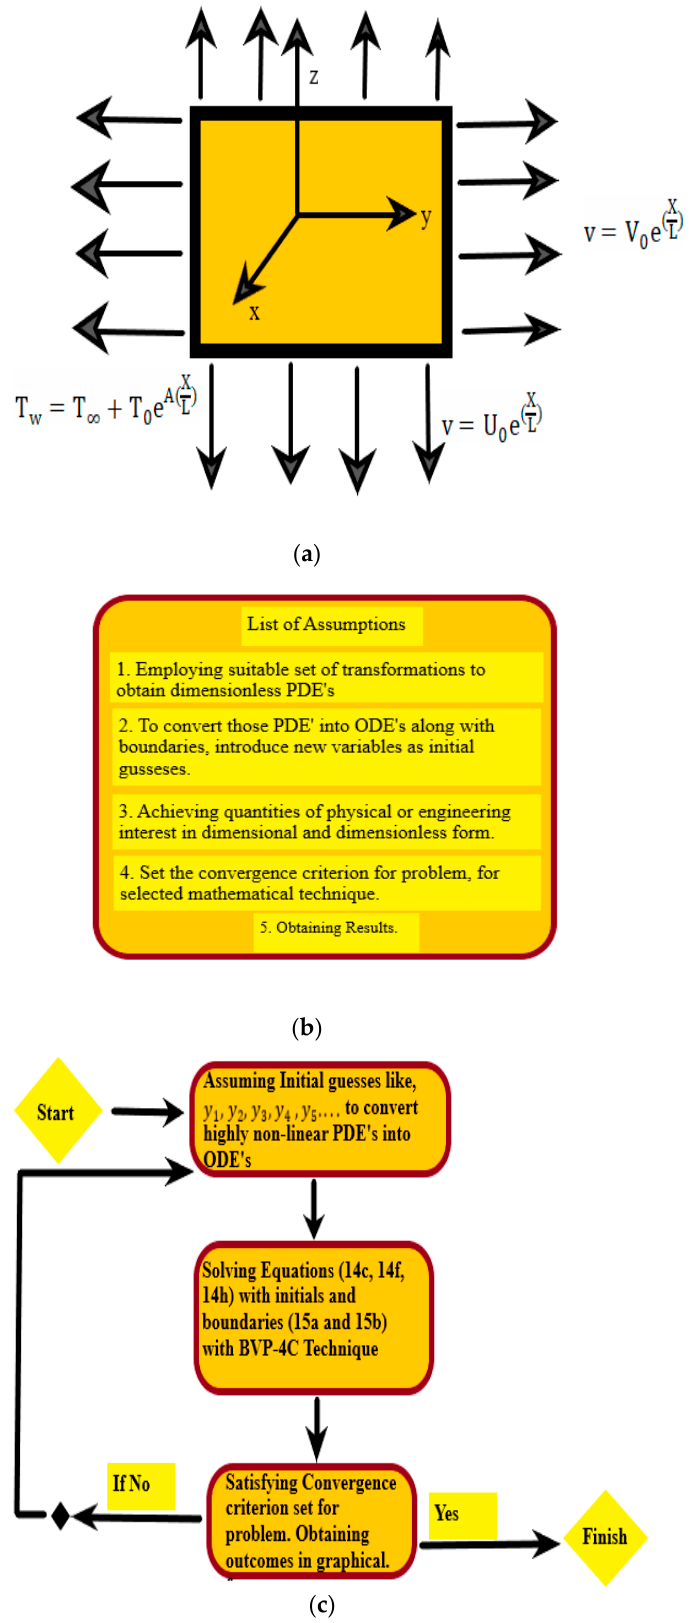
Figure 1. ( a ): The geometry of the problem. ( b ): Assumptions sketch to solve flow governing equations. ( c ): Flow chart of problem illustrating complete cycle.